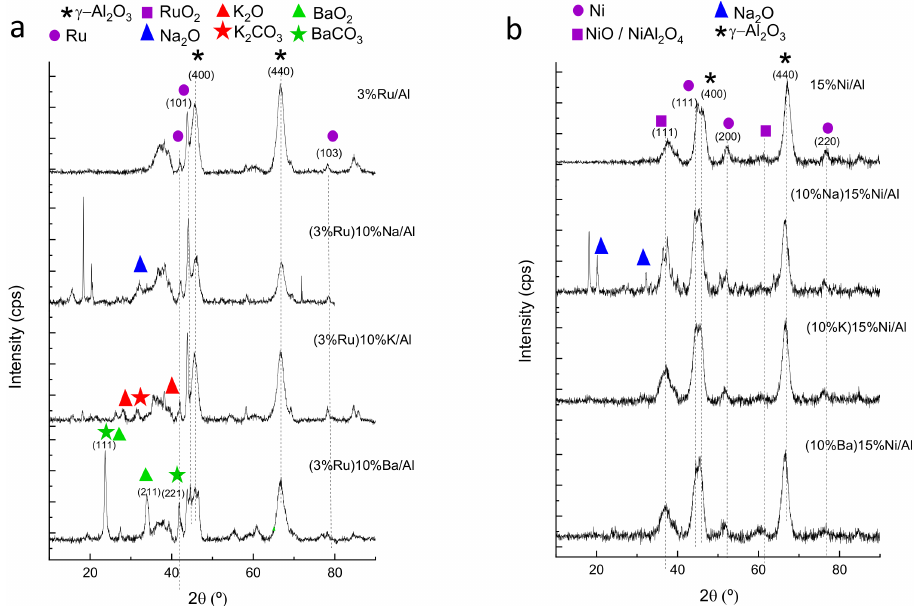
Figure 8. X-ray diffraction peaks for monometallic and bimetallic catalysts before use: ( a ) Ru-based materials, ( b ) Ni-based